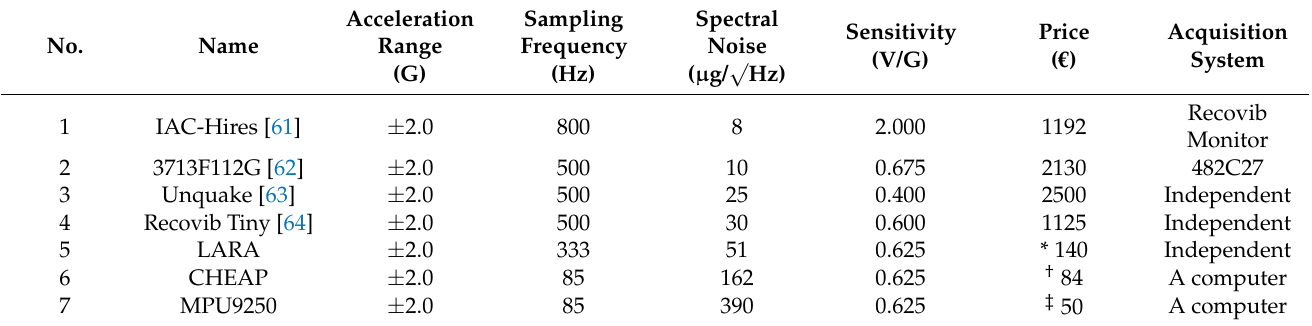
Table 2. Comparison of commercial triaxial MEMS accelerometers with